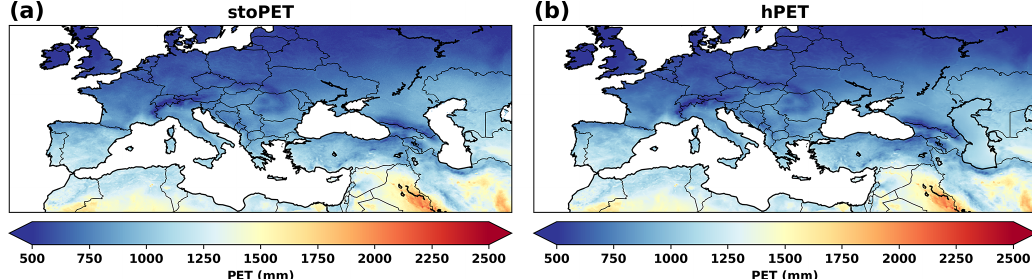
median (red line in Fig. 10b) to hPET and captures the overall variability in the hPET distribution. Figure 11 shows the den- sity plots of the hPET and stoPET data, which indicates that the randomly generated stoPET values represent the